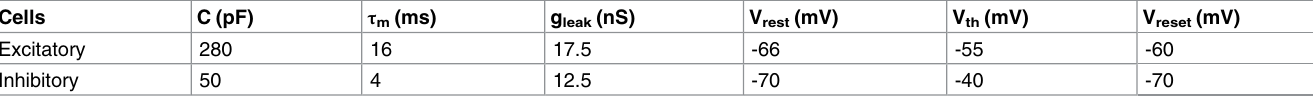
Table 1. Cellular parameters for excitatory and inhibitory (including global) cells.